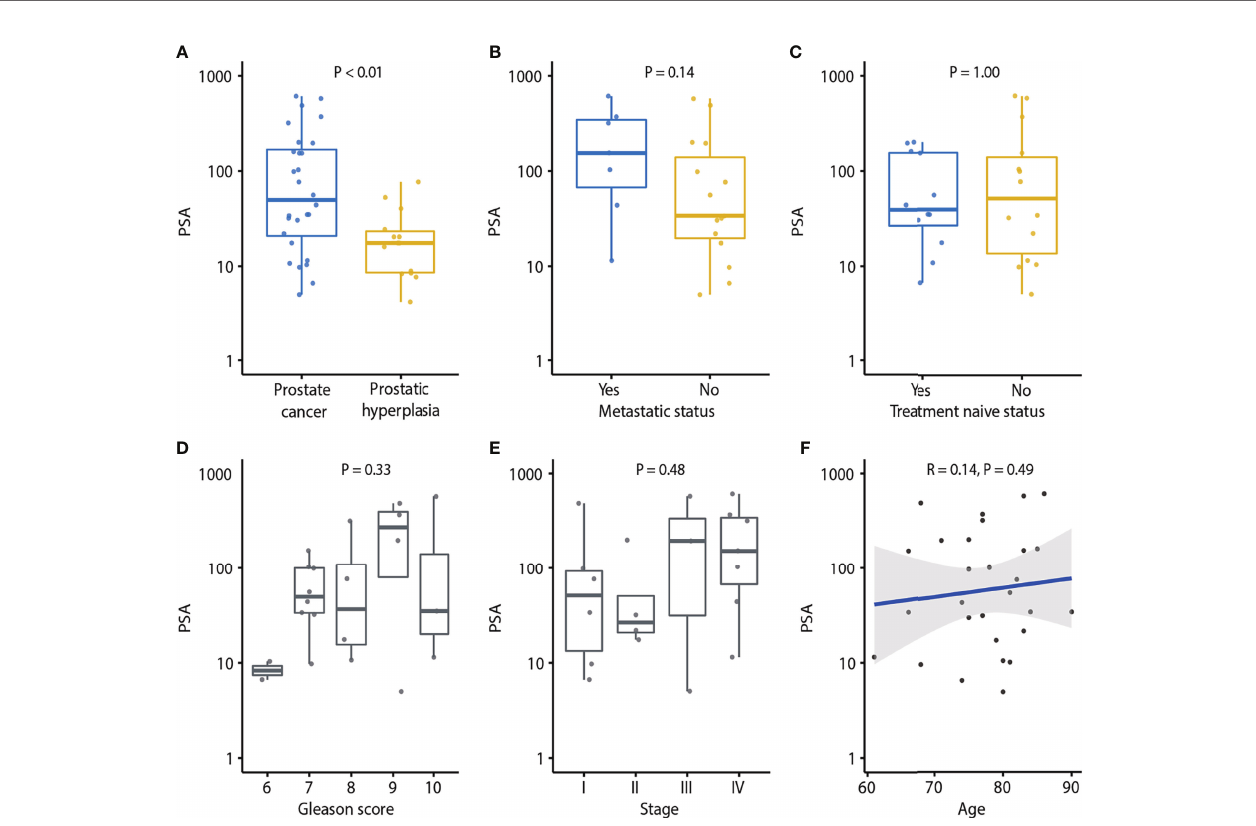
FIGURE 2 | Association of PSA and clinical characteristics of prostate cancer. (A) PSA in prostate cancer and prostatic hyperplasia. P-value was calculated by the Mann-Whitney U test. (B) Association of PSA and metastatic status. P-value was calculated by the Mann-Whitney U test. (C) Association of PSA and treatment naïve status. p-value was calculated by Mann-Whitney U test. (D) Association of PSA and Gleason score. P-value was calculated by the Kruskal-Wallis test. (E) Association of PSA and tumor stage. P-value was calculated by the Kruskal-Wallis test. (F) Association of PSA and age. Spearman ’ s rank correlation coef fi cient and the corresponding P-value are shown. Each dot indicates one